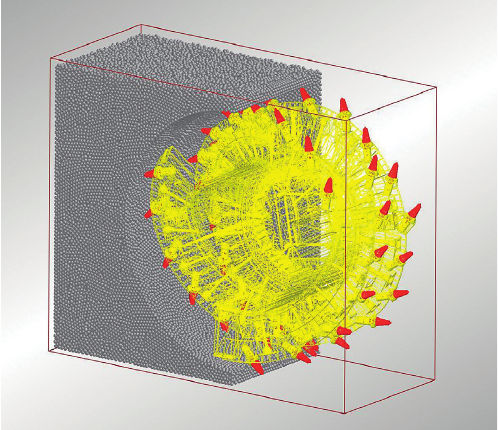
Figure 9: Discrete element model. Table 2: Number of remaining particles and number of average crushing particles for each scheme.